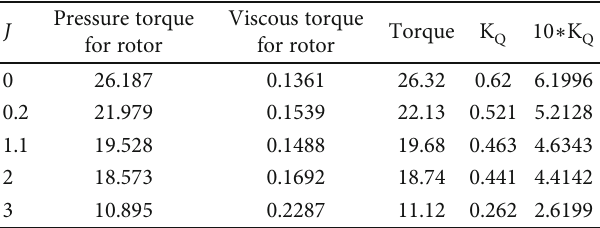
Table 8: Torque force calculated for the linear jet system with a